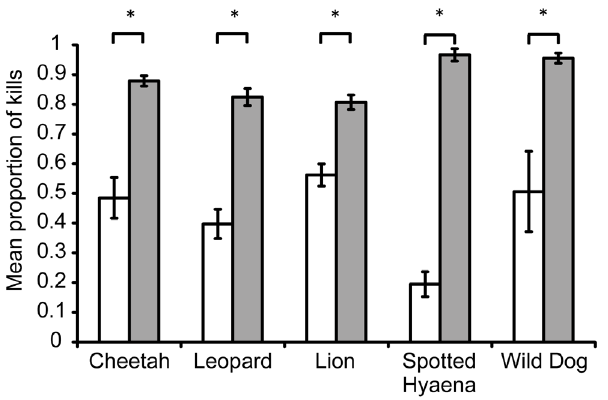
Figure 4. Mean ( 6 SE) proportions of kills falling within the preferred and accessible weight ranges at test sites. The mean proportion of kills made by each of the five large African carnivores at test sites that fall within this study’s preferred (white) and accessible (grey) prey weight ranges. * - significant difference between the proportion of kills in the weight ranges preferred by and accessible to a carnivore.